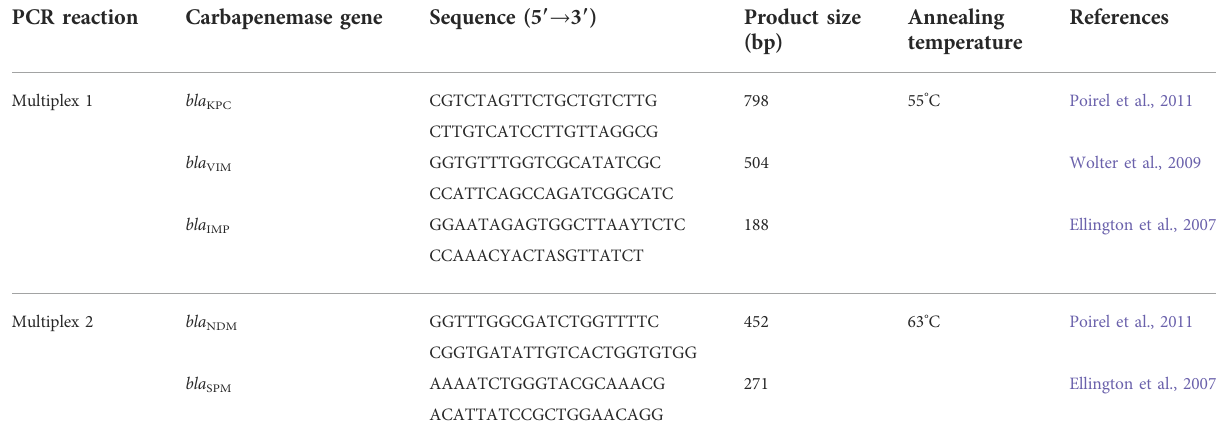
TABLE 1 Conditions and sequence of the primers used in the Multiplex PCR for molecular detection of the carbapenemase genes bla VIM , bla KPC , bla NDM , bla SPM, or bla IMP